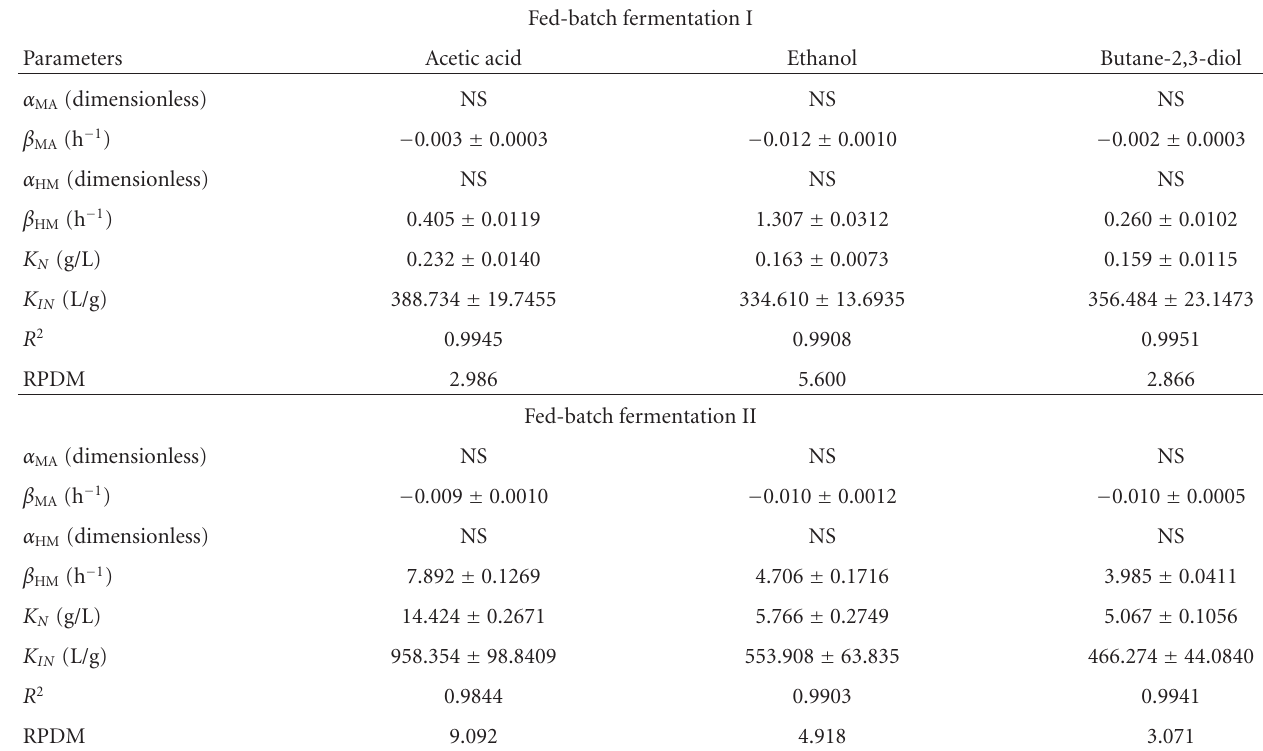
Table 5: Parameter values (means ± SD) of the model (A.9) developed for describing the production of mixed acid metabolites by Ent. faecium CECT